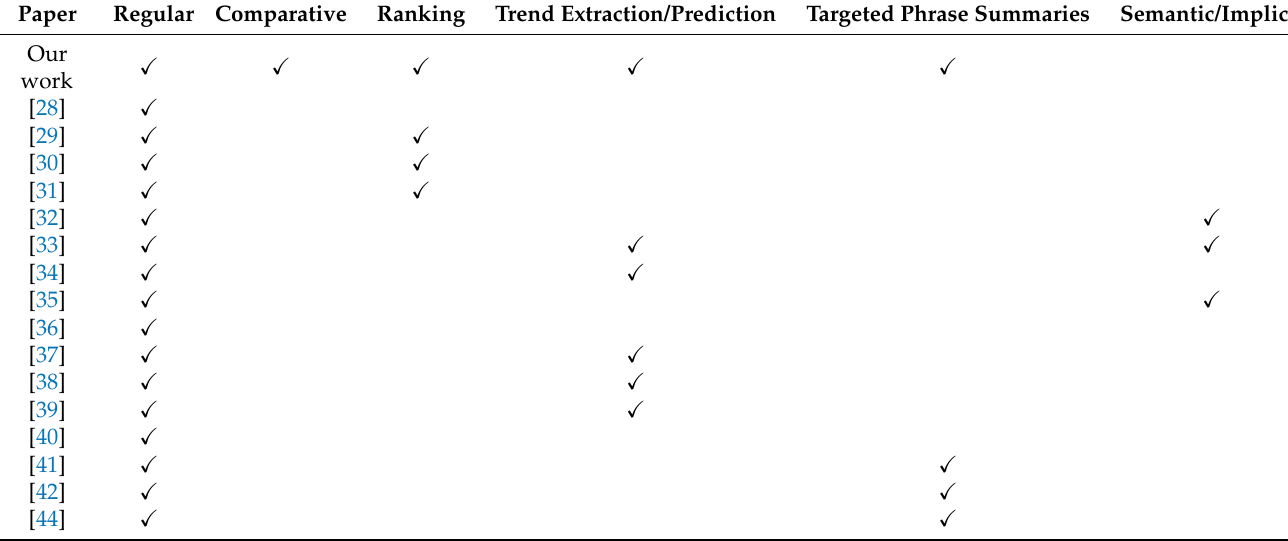
Table 5. Comparison of the range of analyses types achievable in related works. Paper Regular Comparative Ranking Trend Extraction/Prediction Targeted Phrase Summaries